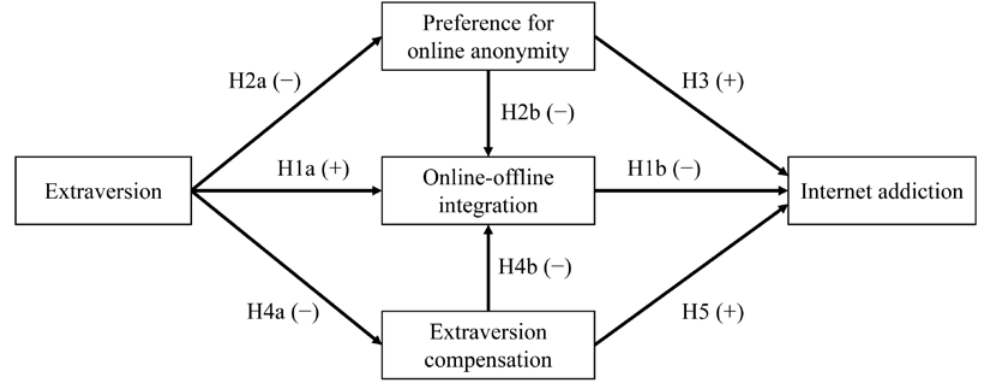
Figure 1. Hypothesized model proposed in this study. + hypothesized positive influence; − hypothe- sized negative influence.